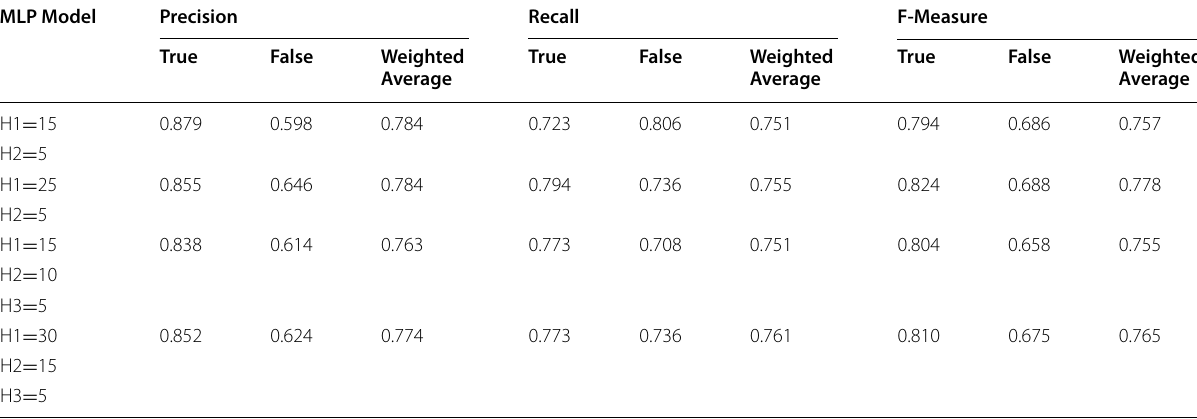
Table 4 Results obtained for Velocity 1.5 dataset MLP Model